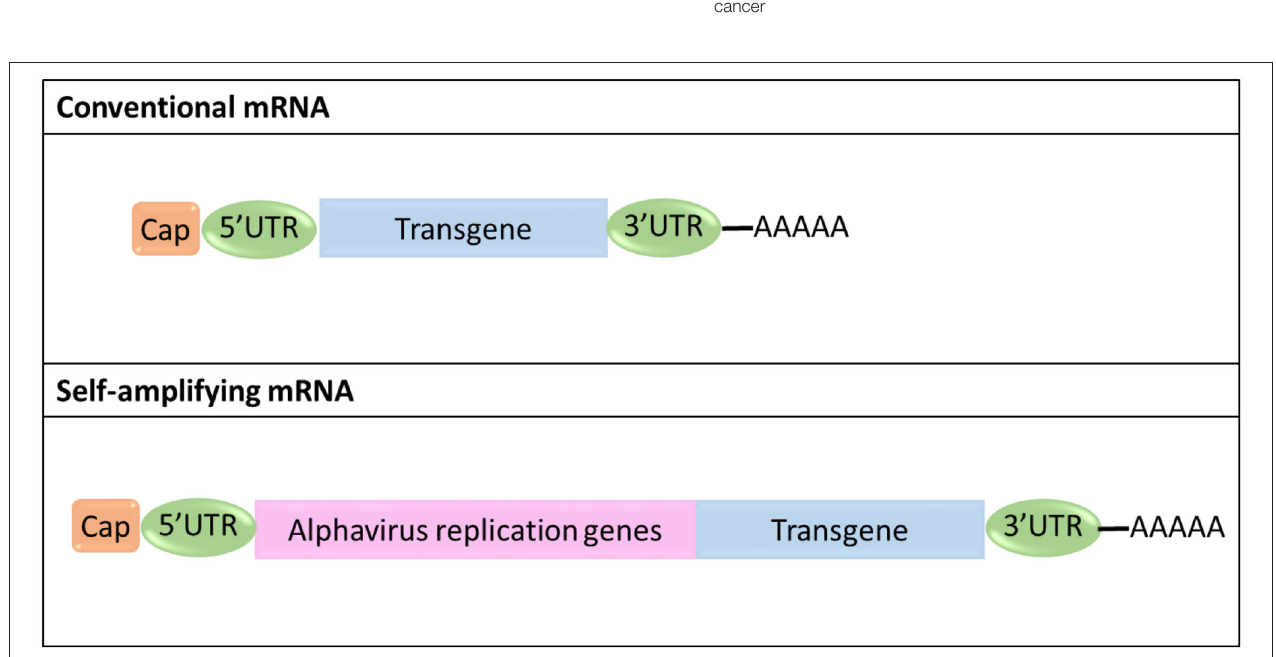
FIGURE 6 | Schematic representation of the structural organization of conventional and self-amplifying mRNA.